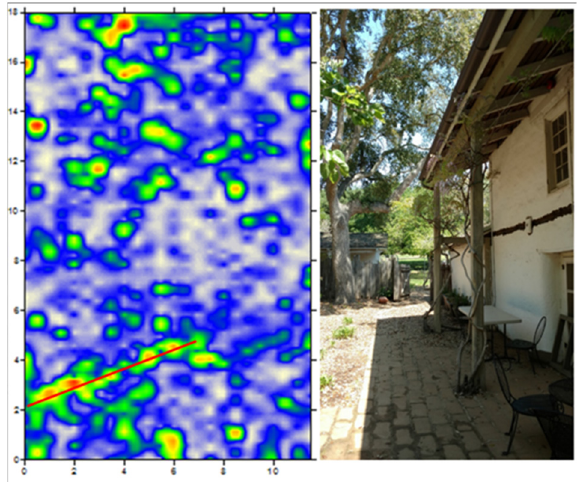
Figure 25. Subsurface features lie adjacent to standing adobe wall at the Castro Adobe, Watsonville.